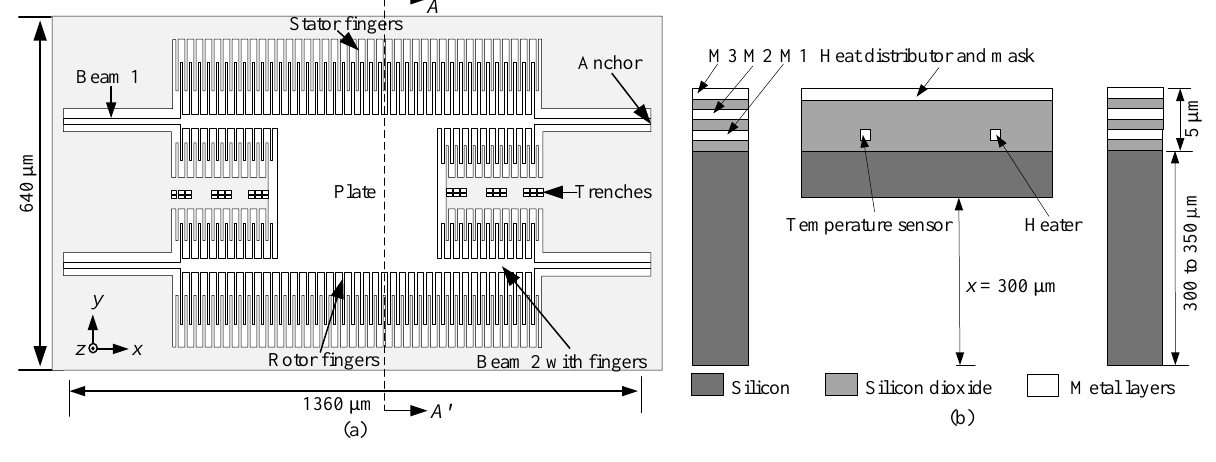
Figure 1. ( a ) Schematic of the top view; ( b ) Cross-sectional view along AA’ showing CMOS layers and the SCS